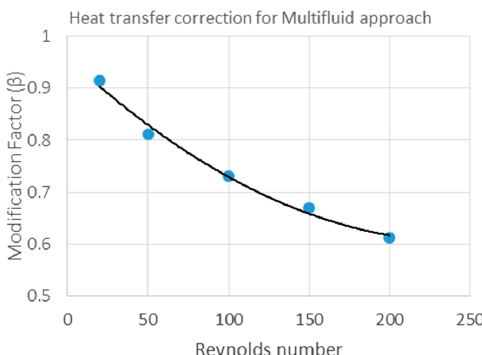
Figure 1. Modification factor fitted over a range of Reynolds number for packed bed of spherical particles (with particle void fraction of 0.35).